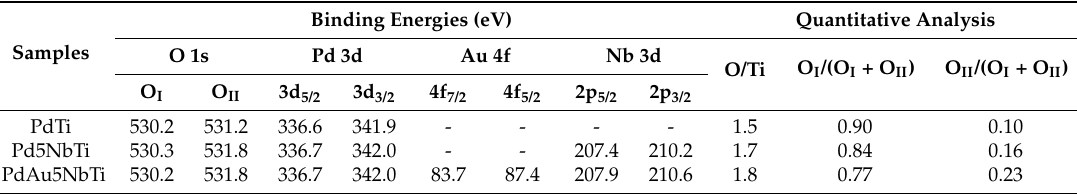
Figure 3. O1s XPS spectra of mono and bimetallic Nb-doped TiO 2 samples (O I in brown line, O II in green line). Table 1. Binding energy and quantitative analysis values of XPS experiments conducted on mono and bimetallic Nb-doped catalysts.